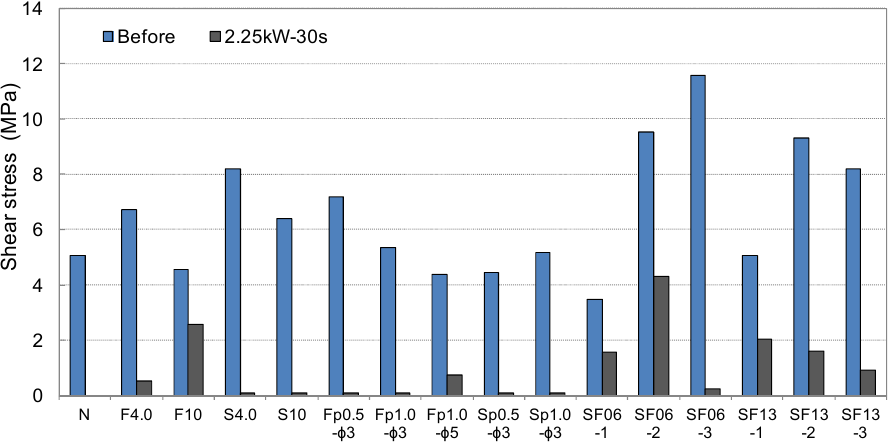
Figure 21. Residual shear bond strength after induction heating of the cementitious joint using a conductive resistor.